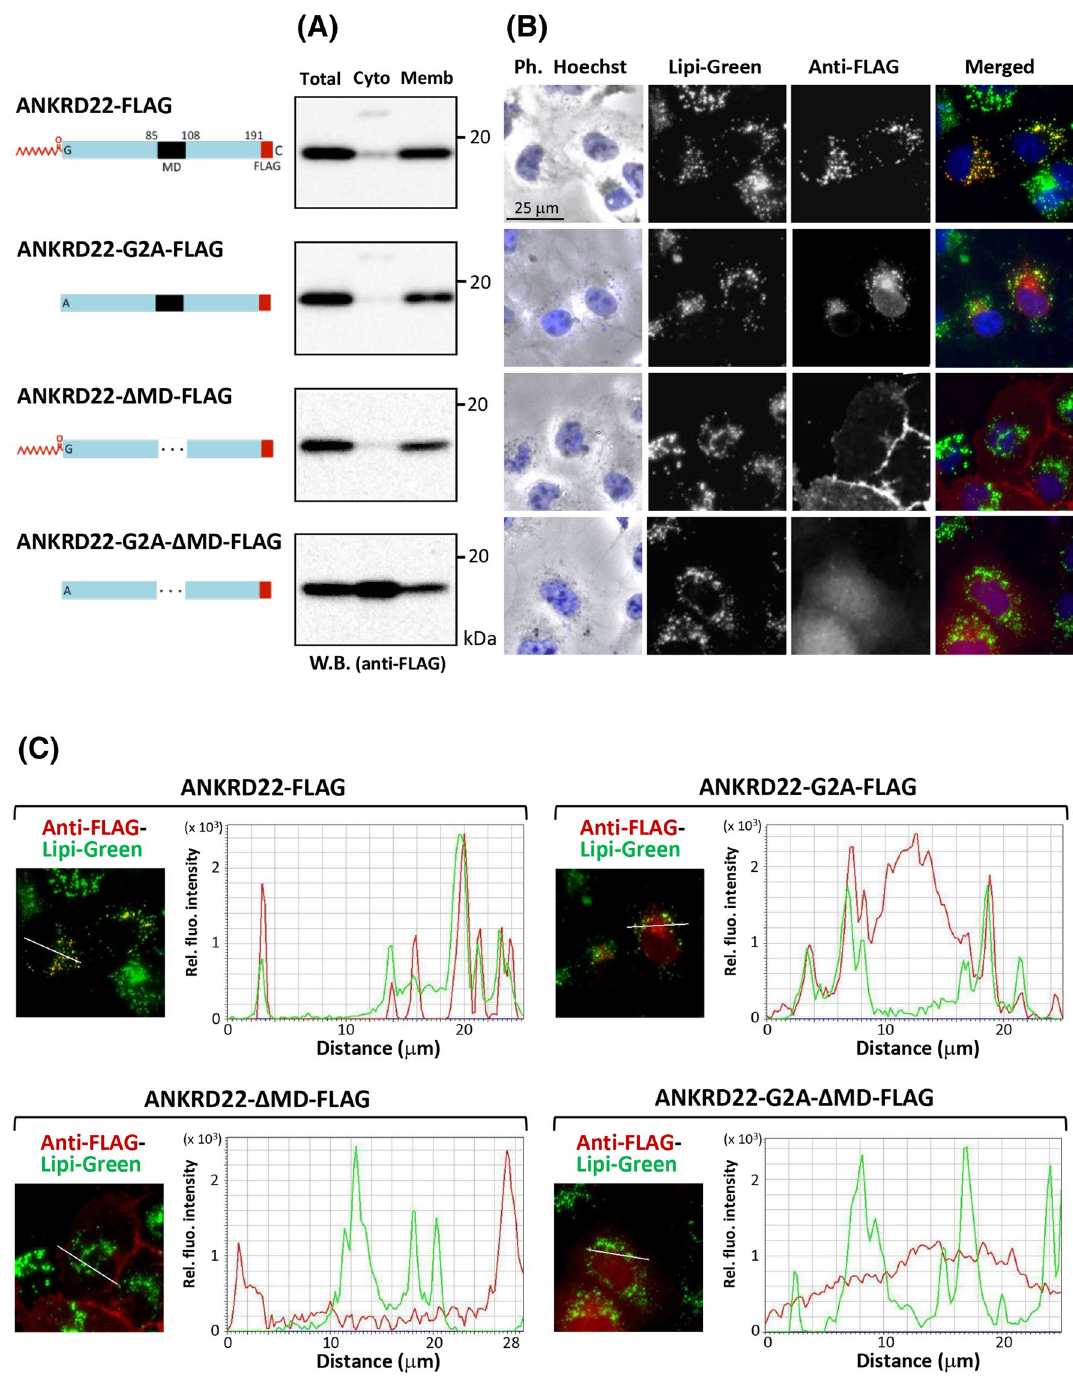
Figure 4. Both protein N-myristoylation and the membrane domain affected the localization of ANKRD22 to LD. Three ANKRD22- FLAG mutants, in which protein N-myristoylation and/or the putative transmembrane domain were deleted, were generated, and their membrane localization and intracellular localization were compared with those of wild-type ANKRD22-FLAG. The experiments were repeated 3 times and the similar results were obtained. A representative data was presented. ( A ) Total cell lysates of COS-1 cells transfected with cDNA encoding ANKRD22-FLAG and its three mutants were separated into cytosolic and membrane fractions using a membrane protein extraction kit (Trident). The presence of proteins in each fraction was determined by Western blotting analysis using anti-FLAG antibody. Using this membrane protein extraction kit, endogenous SAMM50, a membrane protein marker expressed in control non-transfected COS-1 cells, was detected exclusively in the total membrane fraction, whereas GAPDH, a cytosolic marker protein, was detected exclusively in the cytosolic fraction as shown in Supplementary Figure S8. A part of the blot was cropped. The uncropped raw image data for the blots are shown in Supplementary Figure S9. ( B ) Intracellular localization of ANKRD22-FLAG and its three mutants was determined by immunofluorescence analysis of COS-1 cells transfected with cDNA coding these proteins using anti-FLAG antibody. Hoechst and Lipi-Green were used as organelle markers for the nucleus and LD, respectively. ( C ) The results of the line profile analysis of the fluorescence images obtained in ( B ). For this analysis, corresponding line-scan graphs of the relative fluorescence intensities of green fluorescence (green line) and red fluorescence (red line) along the white line indicated in the merged images are